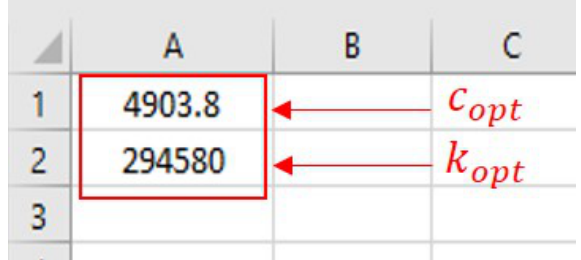
Figure 19. Output vector of the neural